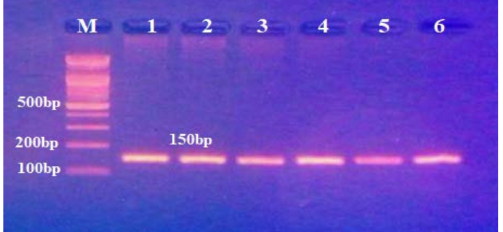
Fig. 2. Gel electrophoresis of nested-PCR products of Human Papillomavirus L1 capsid gene (the second round) stained with ethidium bromide and visualized under ultra-violate. M: DNA marker, Lanes 1,2,3,4,5 and 6: positive results for amplification (150bp). Out of 100 CSs, 13 (13%) were found to be positive for HPV DNA. On the other hand, HPV DNA was successfully isolated from 10 samples (10%) out of 100 urine samples collected from the same